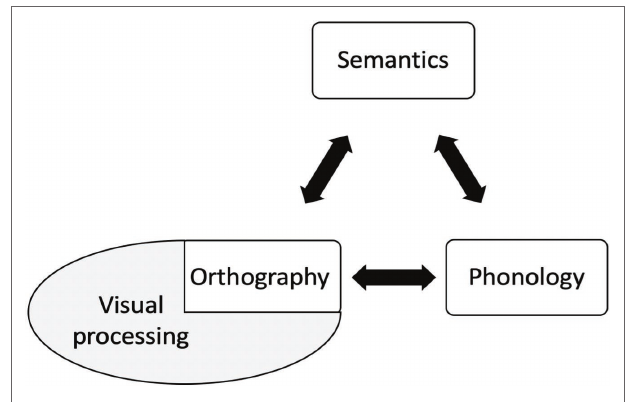
FIGURE 2 | The triangle model (Seidenberg and McClleland, 1989; Plaut,